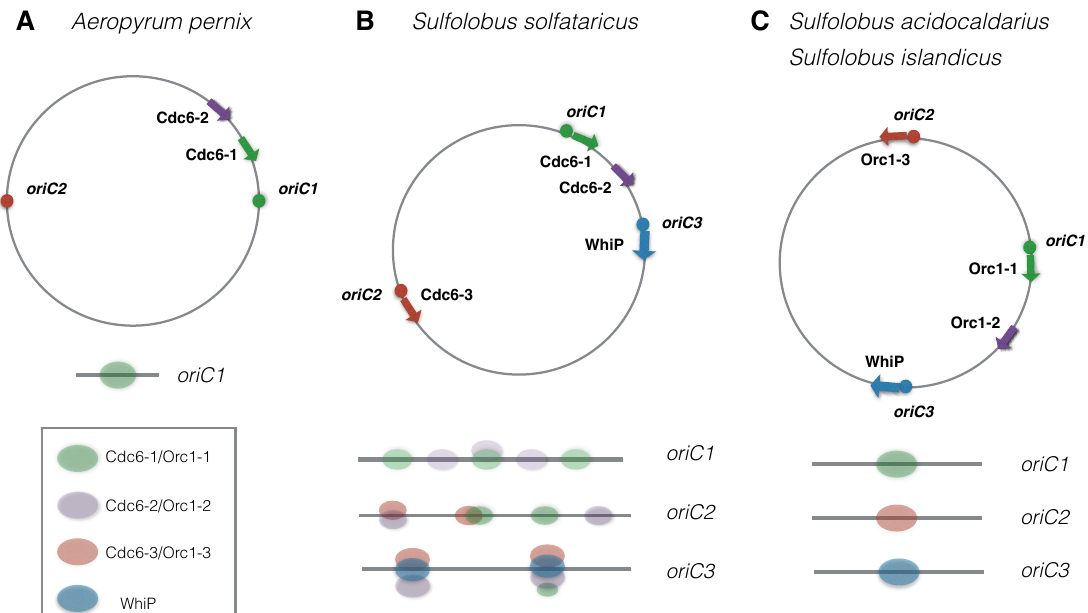
Figure 2. Binding of Orc1/Cdc6 proteins at origins of archaeal chromosomes. ( A ) Aeropyrum pernix Cdc6-1 binds to oriC1 as a monomer; binding to the origin oriC2 has not been investigated; ( B ) Cdc6-1, Cdc6-2, and Cdc6-3 of Sulfolobus solfataricus binds more than one origin each; ( C ) Replication initiation proteins of Sulfolobus acidocaldarius bind only one origin each. Similar to S. acidocaldarius, initiation proteins in Sulfolobus islandicus bind only one origin